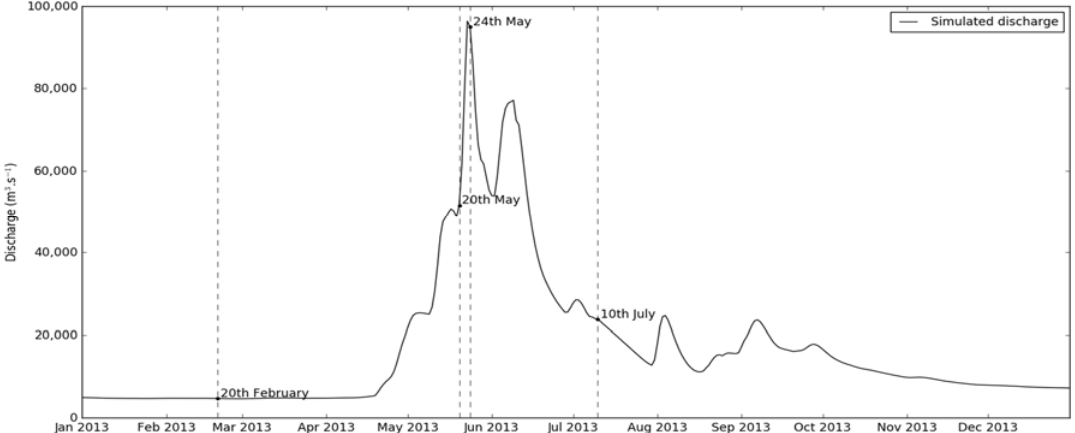
Figure 5. Representation of the modeled discharge at the Yenisei outlet.